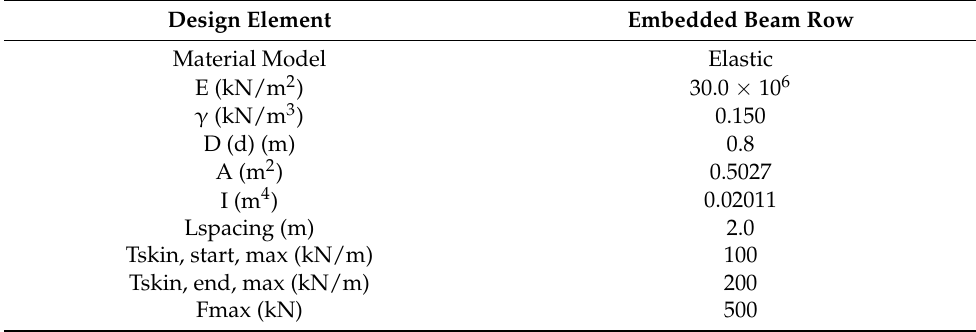
Table 5. Properties of piled-raft foundation as embedded beam row (data from Ref. [69]).